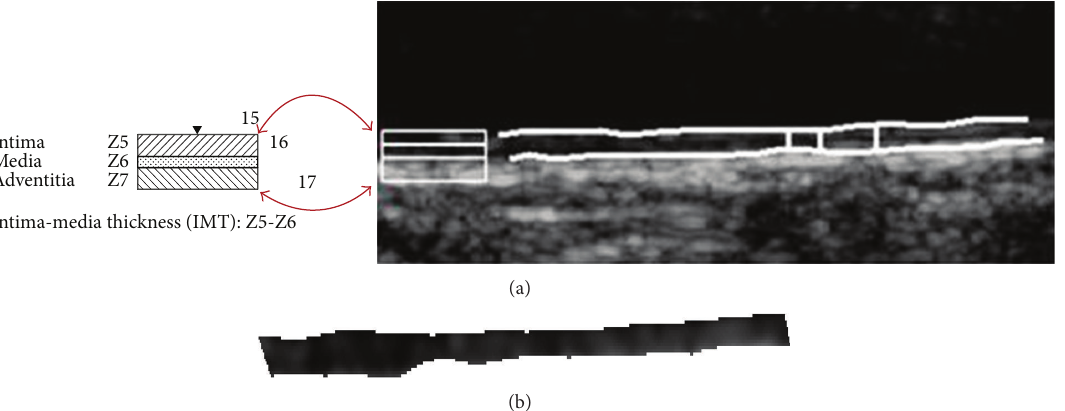
Figure 1: Anatomical locations of the common carotid artery ultrasound image components at the far wall. The IMT is defined as the layer (band) which is comprised by the bands Z5 and Z6 as demonstrated in (a). The intima-media-complex (IMC) in (b) has been extracted using automated segmentation as described in [4, 24], where the IMT aver = 079 mm (between the bands Z5 and Z6, middle bar), IMT max = 0.8367 mm (left bar), IMT min = 0.6356 mm (right bar) and IMT median = 0.75